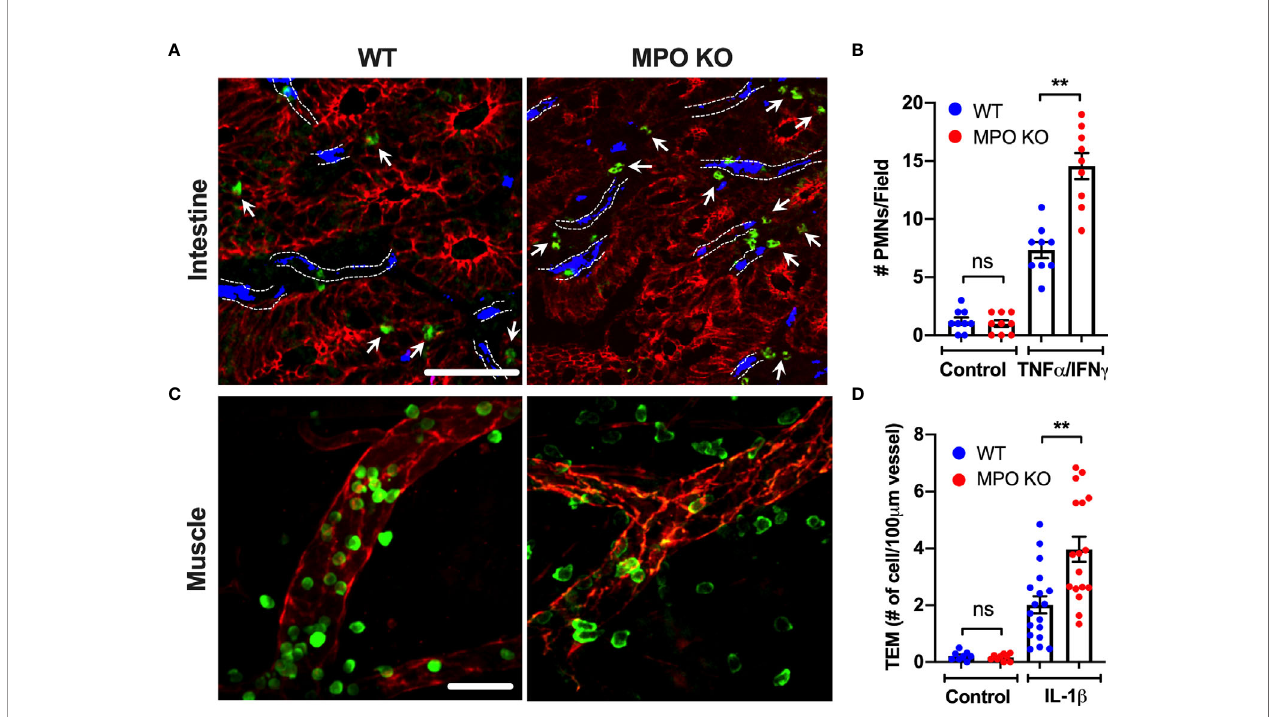
FIGURE 1 | PMN tissue localization is enhanced in the absence of functional MPO. (A, B) In fl ammation of the intestinal mucosa was induced by intraperitoneal administration of TNF a and IFN g (500ng, each 24hr). Immuno fl uorescence analyses were performed on OCT-frozen 10µm-sections. PMNs, intestinal epithelial cells and blood vessel were visualized by S100A8 (green), E-Cadherin (red) and PECAM (CD31, blue) staining respectively. (A) Representative images and (B) quanti fi cation show increased number of tissue-in fi ltrating PMNs in MPO KO mice. Blood vessel locations are highlighted by dotted lines. White arrow point to tissue localized PMNs. (C, D) In fl ammation of the cremaster muscle was induced by intrascrotal administration of IL-1 b (50ng, 4hr). PMNs and ECs were visualized in a whole mount muscle preparation by respective staining with S100A8 (green) and CD31 (red). Consistently, PMN numbers in tissue were signi fi cantly elevated in MPO KO animals. N=3 independent experiments with 3 mice per condition. **p < 0.01. ns, not signi fi